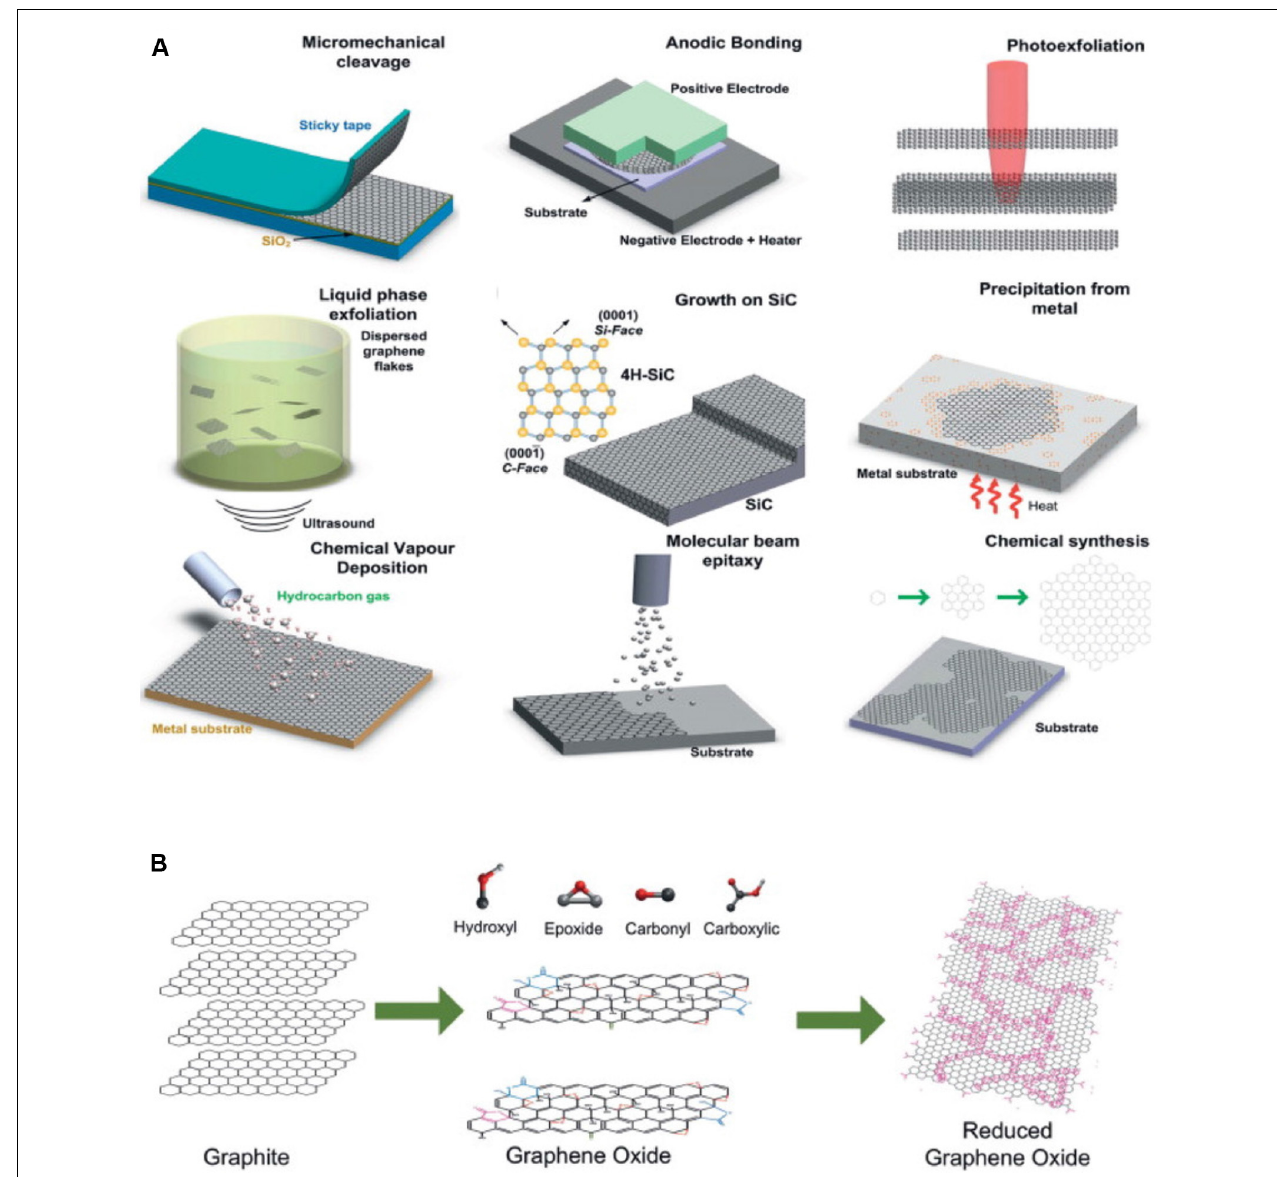
FIGURE 1 | Production of Graphene/Gr oxide (Gr/GO). (A) Gr production methods and (B) GO production and reduction methods. Modified with permission from Bonaccorso et al.